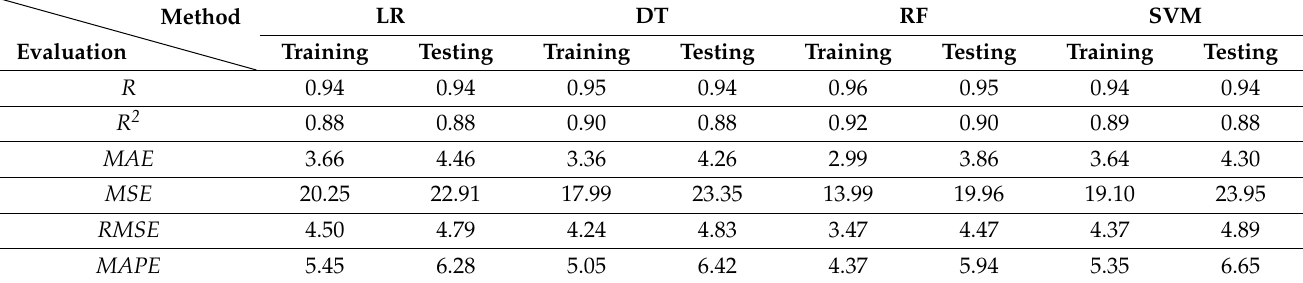
Table 4. Results of predictions with LR, DT, RF, and SVM models with eleven parameters.